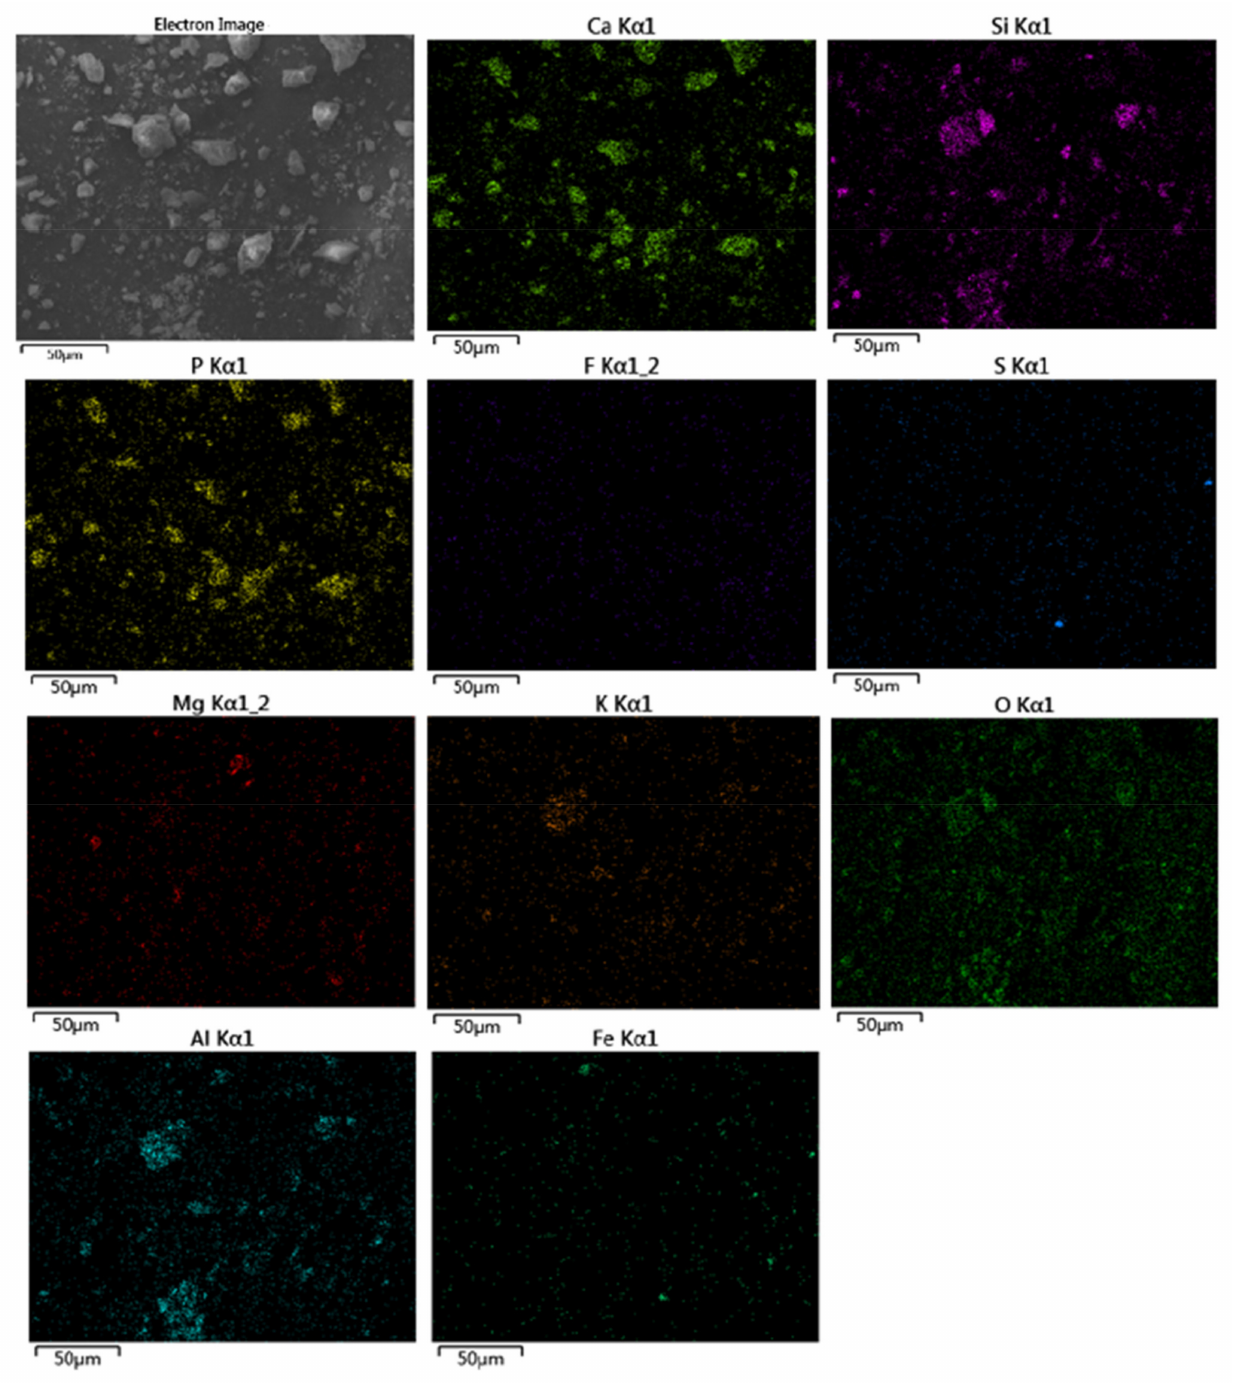
Table 2. Mineral composition of collophanite with particle size of − 75 µ m accounting for 63% identified by AMICS. Sericite Mineral Fluorapatite Quartz Dolomite Pyrite Kaolinite Limonite Barite (Muscovite) Content (wt. %) 79.76 7.17 5.18 4.02 1.53 1.04 0.48 0.29 Mineral Rutile Goyazite Calcite Ankerite Chlorite Zircon Other Content (wt. %) 0.12 0.06 0.05 0.04 0.02 0.01